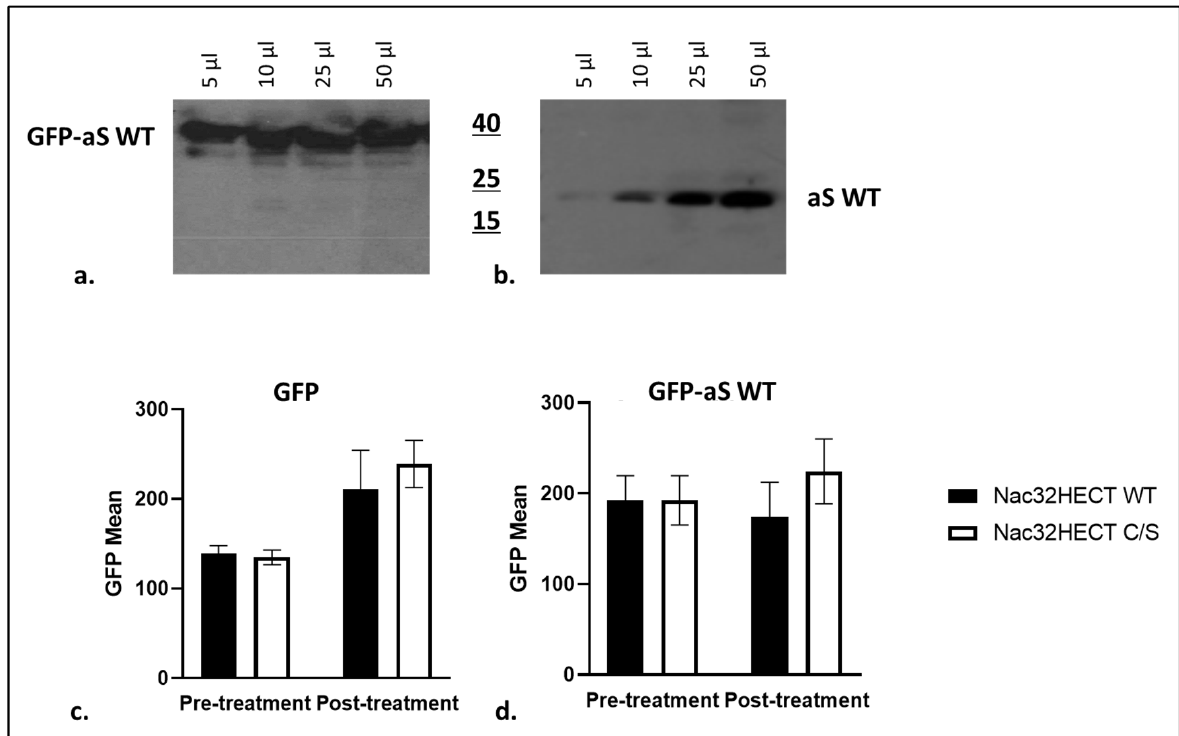
Figure 7. WT Nac32HECT reduces aS intracellular levels. Cells were transduced with RLPs expressing either GFP- aS WT ( panel a ) or aS WT (p anel b ) to assess by western blot the presence of a single band of the expected size in the sample harvested from cells expressing the fusion protein. Next, 293T cells were transduced with RLPs expressing either GFP alone ( panel c ) or GFP-aS WT ( panel d ) and, the day after, with RLPs expressing comparable amounts of WT or C/S Nac32HECT (black and white, respectively). Cells were harvested and green fluorescence derived from GFP was measured by cytofluorimetric analysis, before (pre-treatment) and after (post-treatment) treatment with ubiquibodies. Specifically, the geometric mean of green fluorescence (GFP Mean) was measured as reported in the y axis. 10,000 events were analyzed. Results are expressed as mean ± SD taken from three independent experiments of the cell culture.